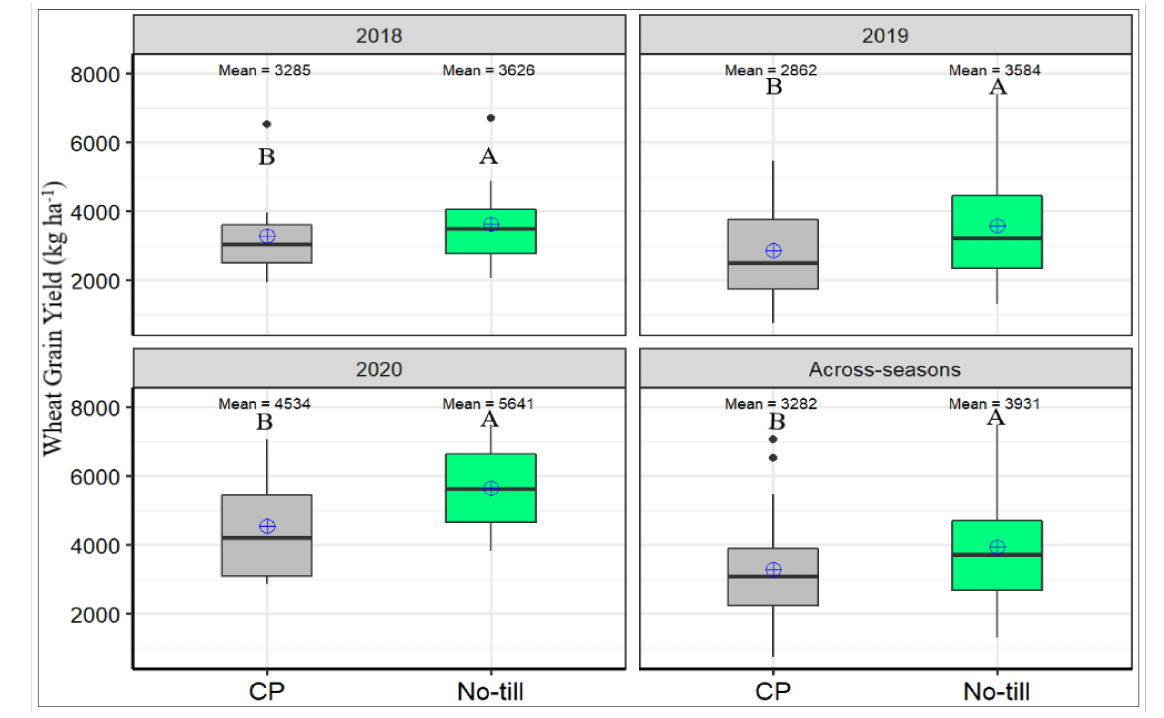
Figure 3. Wheat grain yield from conventional practice and no-till (NT) treatments in 2018, 2019, 2020 and across the growing seasons. Means with different letters (A, B) in the same season are significantly different at p < 0.05.